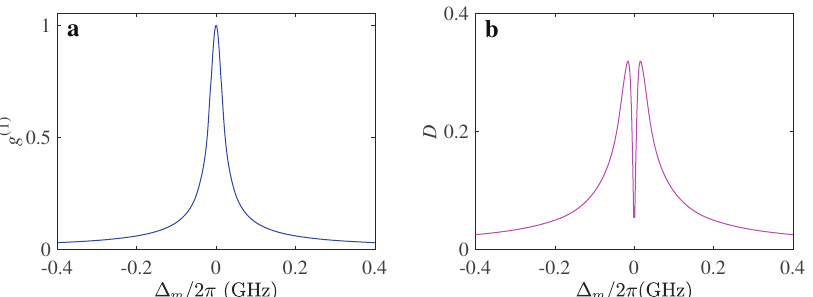
Fig. 4 Quantum coherence degree and indistinguishability. a First-order coherence degree g (1) and b indistinguishability D versus Δ m for θ = 0 or θ = π . The corresponding parameters are J /2 π = 5 MHz and Γ /2 π = 6 MHz, and the other parameters are the same as those in Fig. [Fig. 3a, b, d, and e], i.e., E N = G a ! b = G b ! a = 0. However, when there is a slight frequency detuning between the magnon and photon modes (near the EPs-like), the entanglement and one-way steering gradually appear, and both the populations of the two modes are always <1 ( 〈 b † b 〉 < 1, 〈 a † a 〉 < 1), which is a prerequisite for generating the desired quantum correlations 8 .